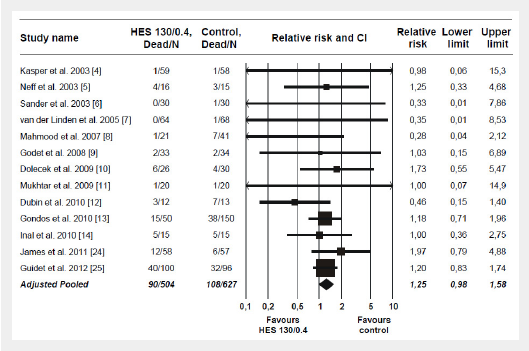
Relative risk of mortality after HES 130/0.4 infusion in RCTs. Pooled relative risk adjusted for publication bias. For trials with more than one control group, data for the different control groups were pooled [8, 13]. In one trial with mortality reported separately for the first 24 hours and thereafter, the data for the two time periods were pooled [12]. Error bars indicate CI. Data points scaled according to meta-analytic weight. Abbreviations: CI, 95% confidence interval; HES, hydroxyethyl starch; RCT, randomised controlled